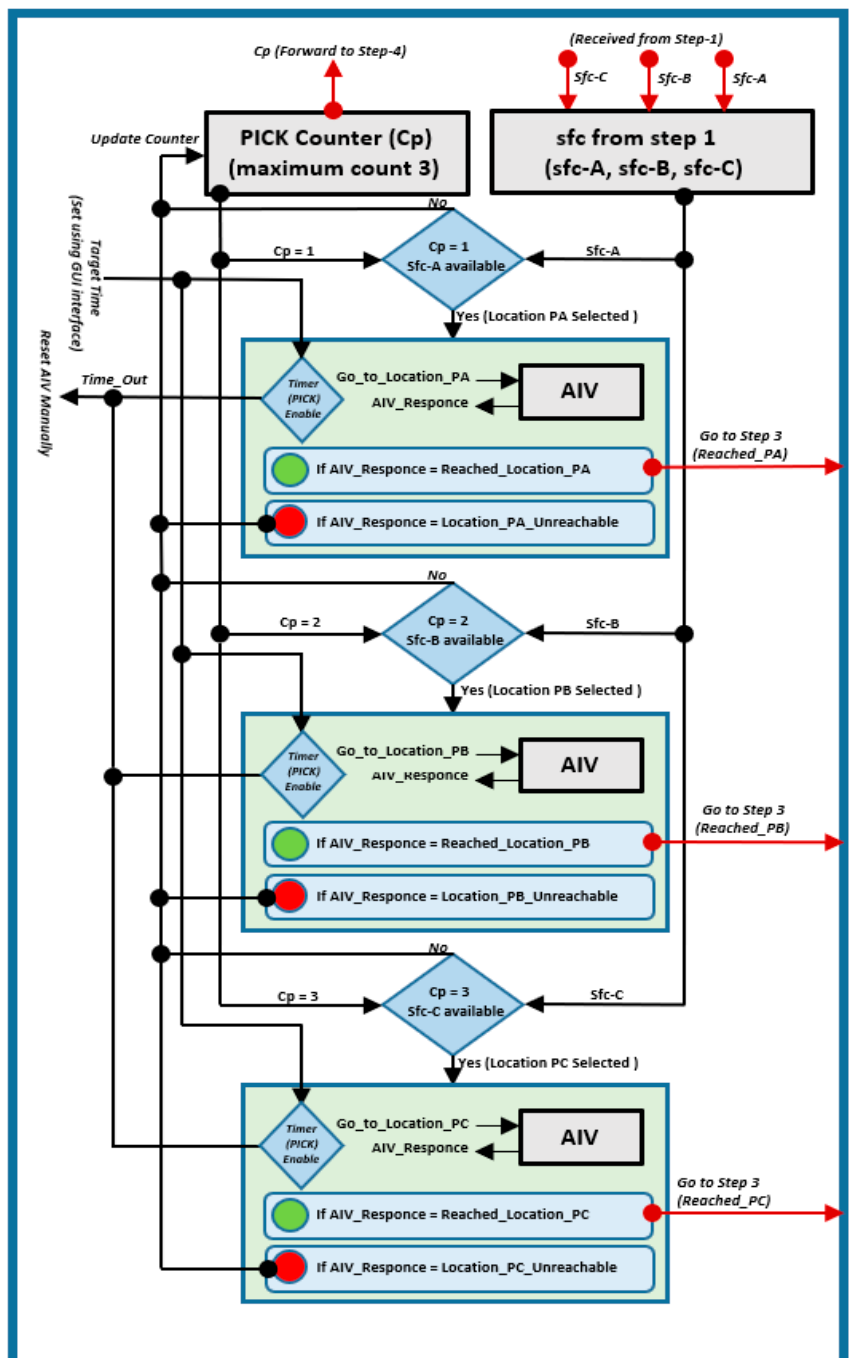
Figure 11. Pickup location selection.